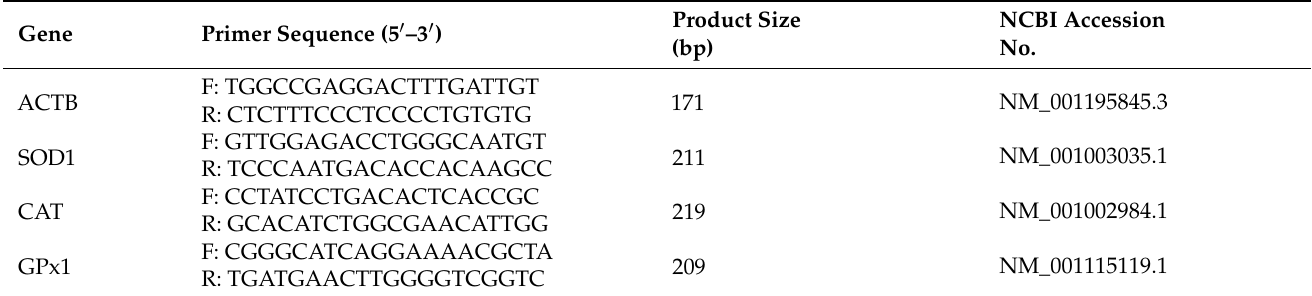
Table 1. Primer sequence used for the analysis of gene